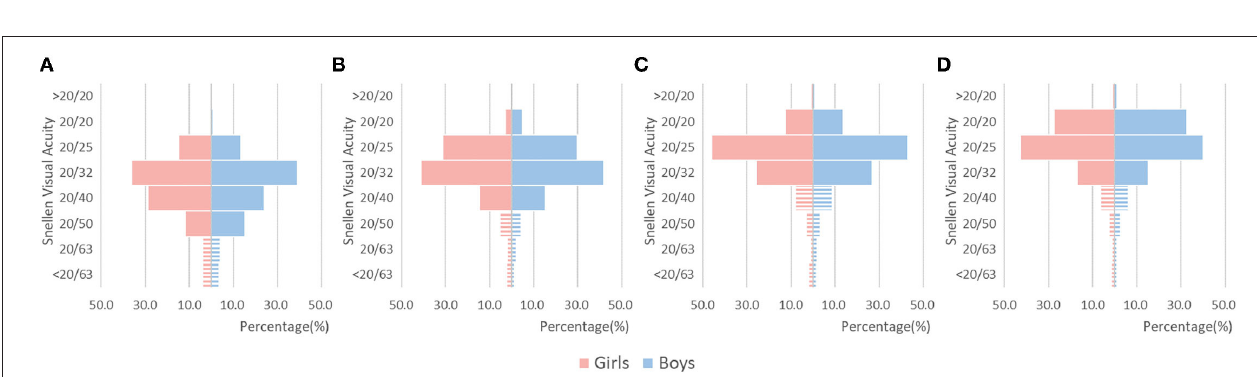
FIGURE 1 | Distribution of uncorrected visual acuity (UCVA) in the worse eye. Lines and corresponding accumulating percentages denoted reduced visual acuity proportions that should be referred according to target conditions. Each subscript letter denotes a subset of age categories whose column proportions do not differ significantly from each other at the 0.05